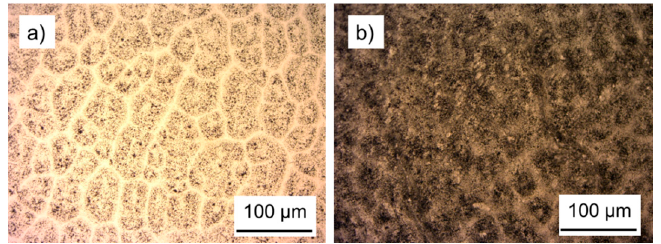
Figure 9. Optical micrographs of PLA films with 10% filler content showing ( a ) poor dispersion of carbon particles after casting from solution and ( b ) improved dispersion after repeated hot-pressing.